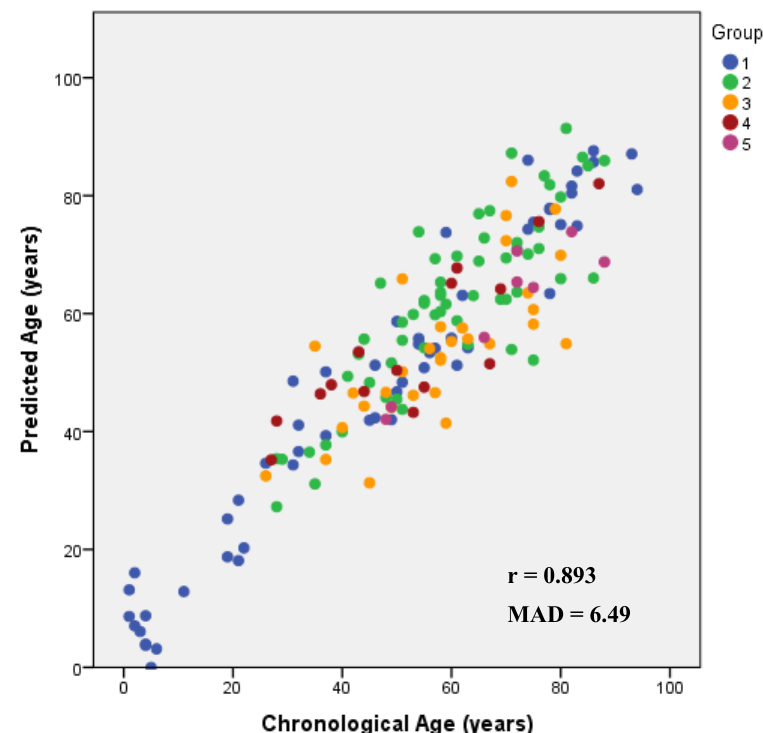
Figure 2. Predicted age versus chronological age using the multi-tissue APM developed for ELOVL2 , C1orf132 and KLF14 genes including blood samples from living individuals (1), blood samples from deceased individuals (2), bone samples (3), tooth samples from living individuals (4) and tooth samples from deceased individuals (5). The corresponding Spearman correlation coefficients (r) are depicted inside each plot.